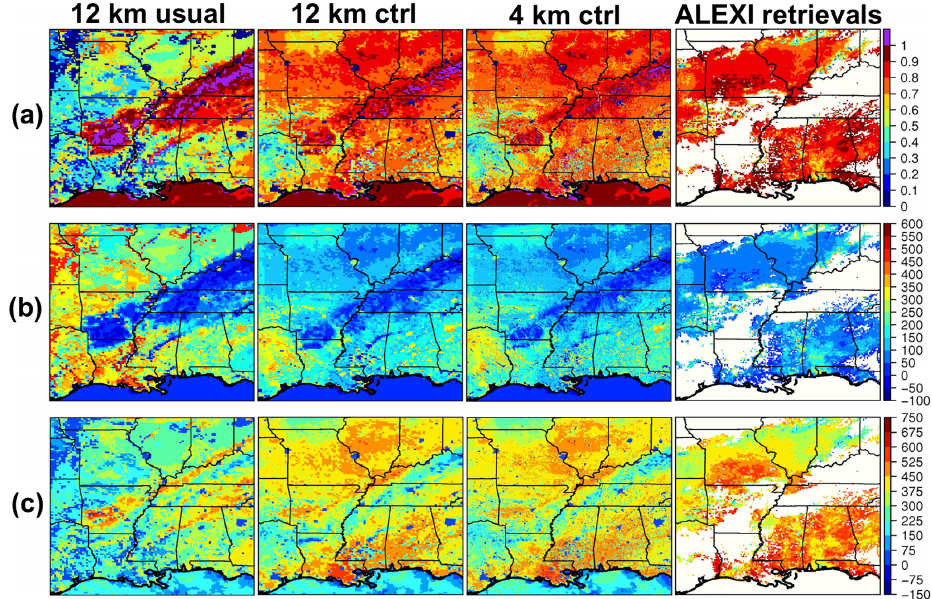
Figure 5. Comparing (a) evaporative ratio, unitless, defined as latent heat / (latent + sensible heat); (b) sensible heat (Wm − 2 ); and (c) latent heat (Wm − 2 ) from three NUWRF simulations (first three columns) with the NOAA operational 0.08 ◦ × 0.08 ◦ ALEXI retrievals (right), on 11 September 2013. Control is denoted by